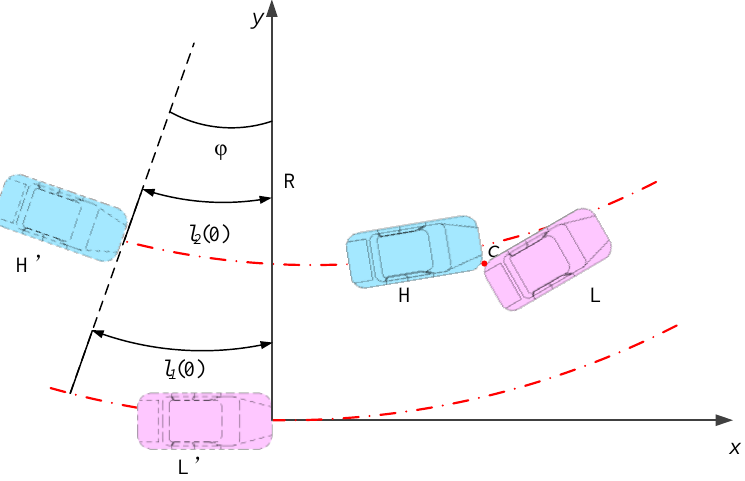
Figure 18. The positions of cut-in vehicle L and host vehicle H in the curved lane.